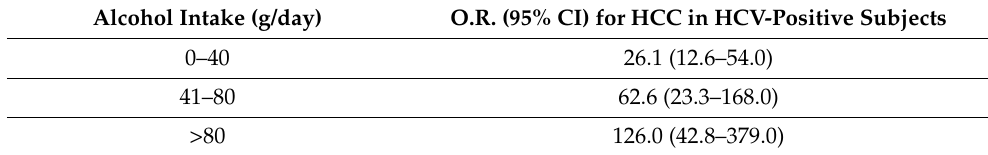
Table 4. Evidence for the dose-dependent effect of alcohol intake in HCV-positive subjects on the risk of HCC (adapted from